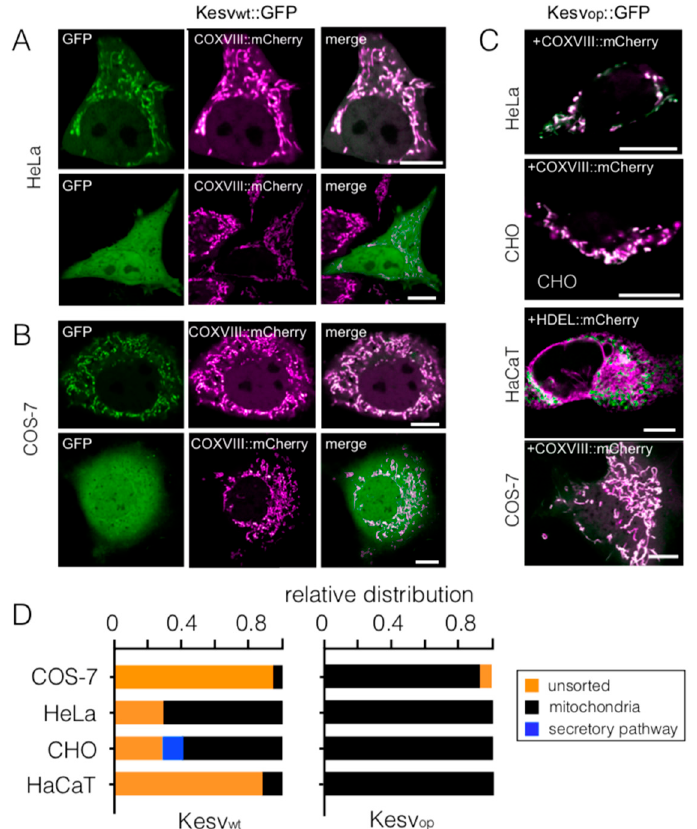
Figure 3. Sensitivity of channel sorting to codon optimization is conserved in mammalian cells. Fluorescent images of HeLa ( A ) and COS-7 cells ( B ) transfected with Kesv wt . In both cell types the channel exhibited either a clear-cut sorting to the mitochondria (top row) or a unsorted phenotype with GFP fluorescence throughout the cell (lower row). Images show: the GFP tagged Kesv channel (green, first column) and fluorescence from mitochondrial marker COXVIII::mCherry (ma- genta, second column). Merged images are in the 3 rd column. ( C ) Fluorescent images of different mammalian cells trans- fected with Kesv op . The images are overlays of GFP fluorescence (green) and fluorescence from mitochondrial marker COXVIII::mCherry (magenta) (HeLa, CHO, COS-7) or from ER marker HDEL::mCherry (HaCaT). Scale bars 10 μ m. ( D ) Mean relative distribution ± SD for localization of the wt channel (Kesv wt , left) or codon-optimized channel (Kesv op , right) in mitochondria (black), secretory pathway (blue) or unsorted channels (orange). (Data from n ≥ 3; n ≥ 56 cells per condi- tion).